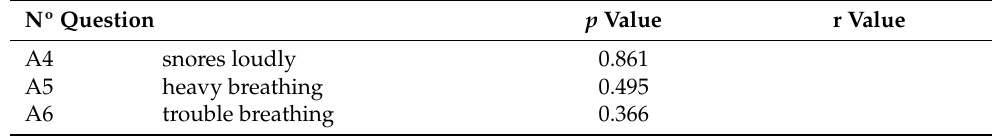
Table 6. Sleep disorders according to caries risk level; Mann–Whitney (MW) test results and Spear- man’s r correlation